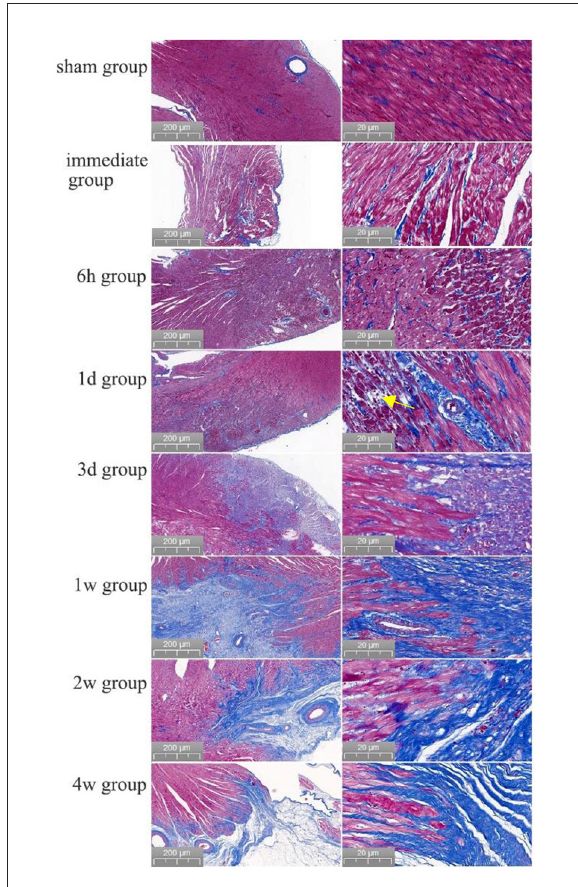
FIGURE3 Evolution of myocardial necrosis at different time periods before and after pulsed ablation (Masson staining). In the preoperative heart, the myocardium tissue were neatly arranged and tightly packed. Immediately after the operation, it was obvious that the ablation boundary was clear, the myocardium tissue were swollen, and the cell gap became larger. Then, 6h post-ablation, the boundary of PEF ablation was clearer, the myocardial cells were swollen, and the cell gap became larger; besides, the myocardial bundle was broken into myocardial fragments, and red blood cells appeared in the myocardial cell gap. At 1 day post-ablation, the ablation boundary was still clear, and the cardiomyocytes had begun to atrophy with a large frequency of erythrocyte infiltration (shown by yellow arrows). At 3 days post-ablation, the ablation boundary was clear, and the cardiomyocytes were atrophied and necrotic, with clustered nuclei and aggregated fibrous structures. At 1 week post-ablation, the ablation boundary was clear, most of the myocardial tissue in the ablation area had disappeared, the structure was intact with fibrotic replacement, and the vascular structure was intact without damage. At 2 weeks, the ablation boundary was clear, the myocardial cells in the ablation area had basically disappeared with fibrous connective tissue replacement, and the vascular structure was intact. After 4 weeks, the ablation boundary was clear, the myocardium tissue in the ablation area had almost completely disappeared, the fibrous structure was intact, and the vascular structure was intact.